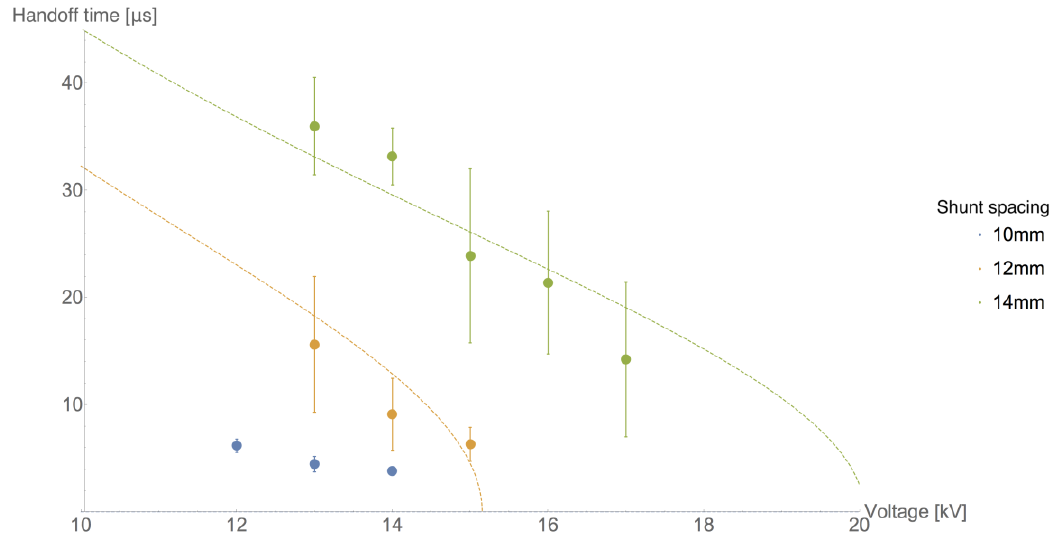
Figure 8. Time of current handoffs for different voltages and shunt spacings.